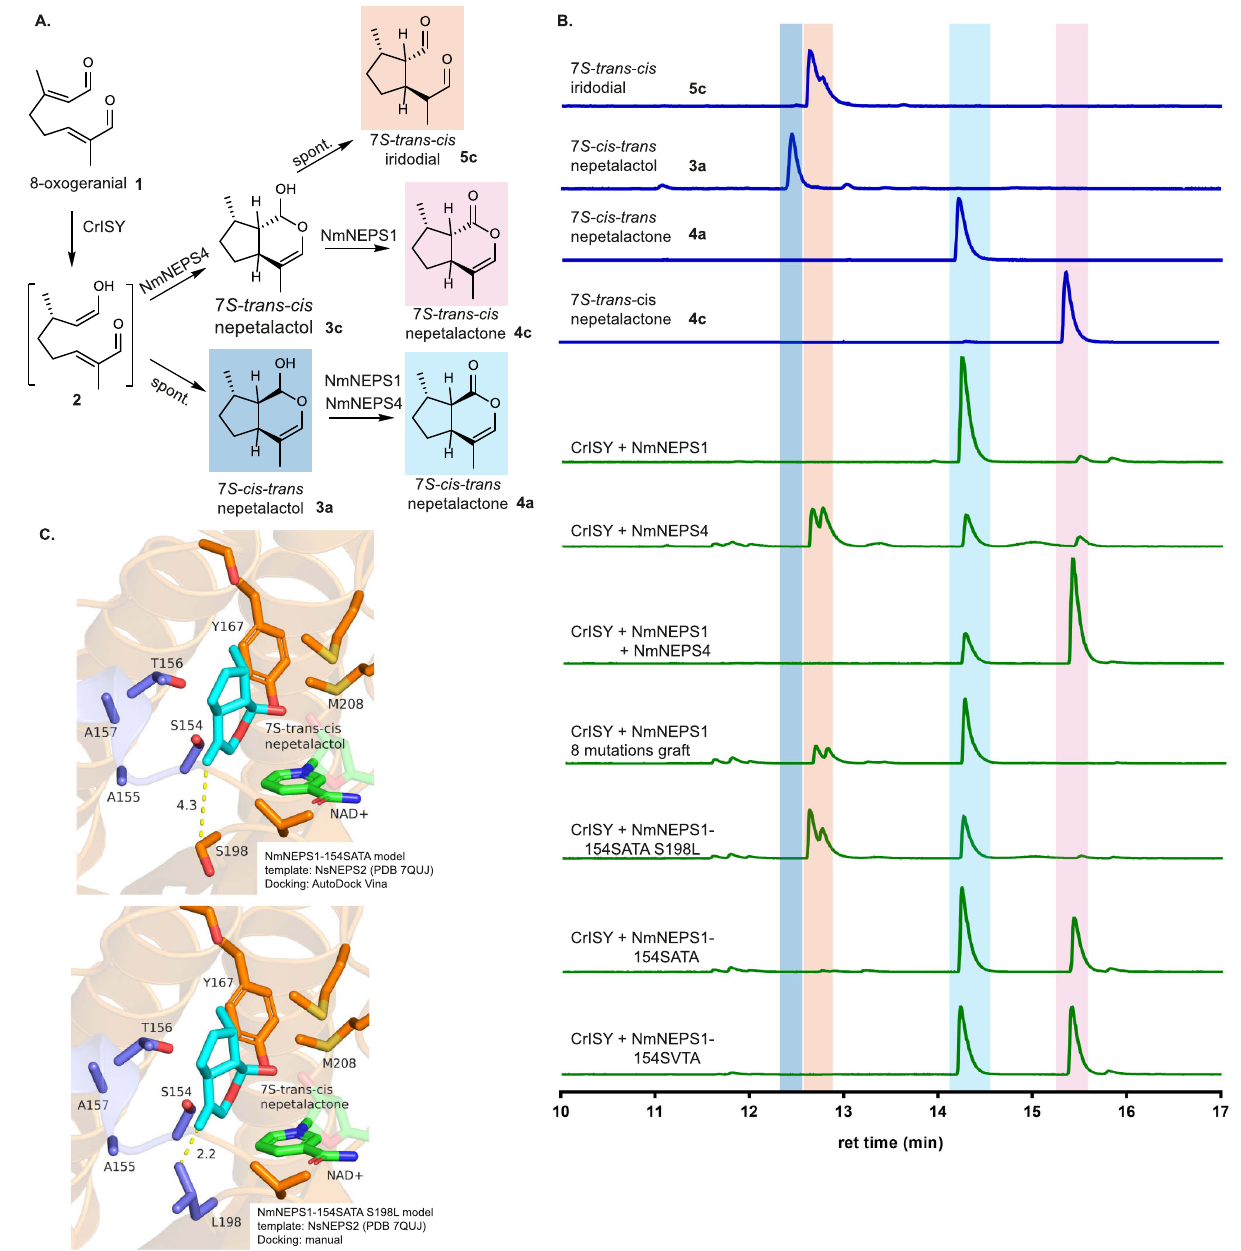
Fig. 3 | Decoupling of cyclization and dehydrogenation of 7 S-trans-cis activity. A Existing enzymes have onlypartialrolesin cyclization(NmNEPS4) and oxidation (NmNEPS1) of 7 S-trans-cis nepetalactol 3c . B NmNEPS1 was engineered to perform both cyclization and oxidation to form 7S-trans-cis nepetalactone 4c . The best variant found (NmNEPS1-154SVTA) is able to produce signi fi cantly more 4c than